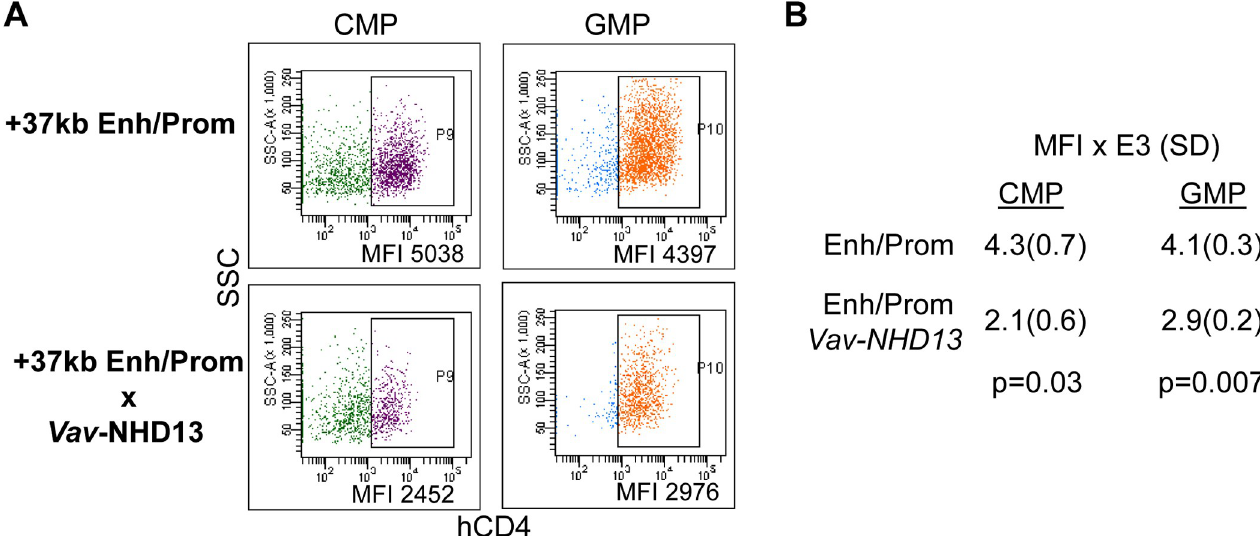
Fig 7. Expression of a Cebpa +37 kb enhancer/promoter transgene is reduced in hematopoietic progenitors with increased HoxA9. A) Representative flow cytometry showing expression of the Cebpa +37 kb enhancer/promoter (Enh/Prom)-human CD4 (hCD4) transgene after breeding to introduce one Vav - NUP98-HOXD13 (NHD13) allele. SSC—side scatter. B) The geometric mean fluorescence intensity (MFI) for hCD4 within CMP or GMP expressing the transgene is shown (mean and SD from three determinations).